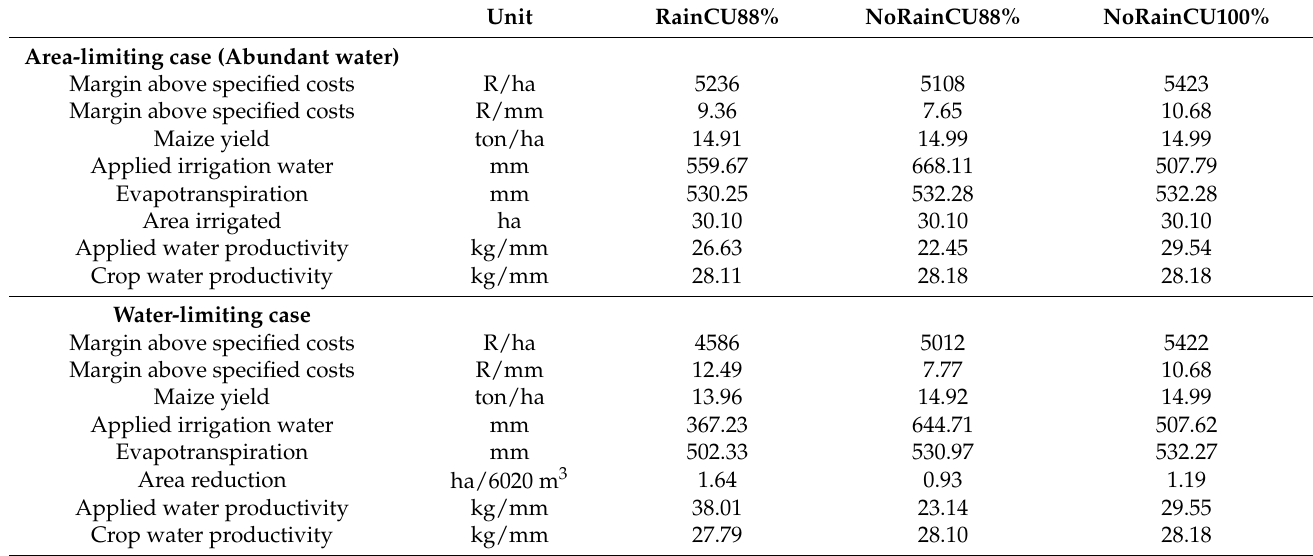
Figure 10. Area irrigated and maize yield as a function of water availability for the water-limiting and area-limiting cases using a non-uniform application in the presence of rainfall. Table 1. Economically optimized water use for the area-limiting and land-limiting cases for a uniform (CU100%) and non-uniform (CU88%) water application in the presence of rainfall (Rain) and no rainfall